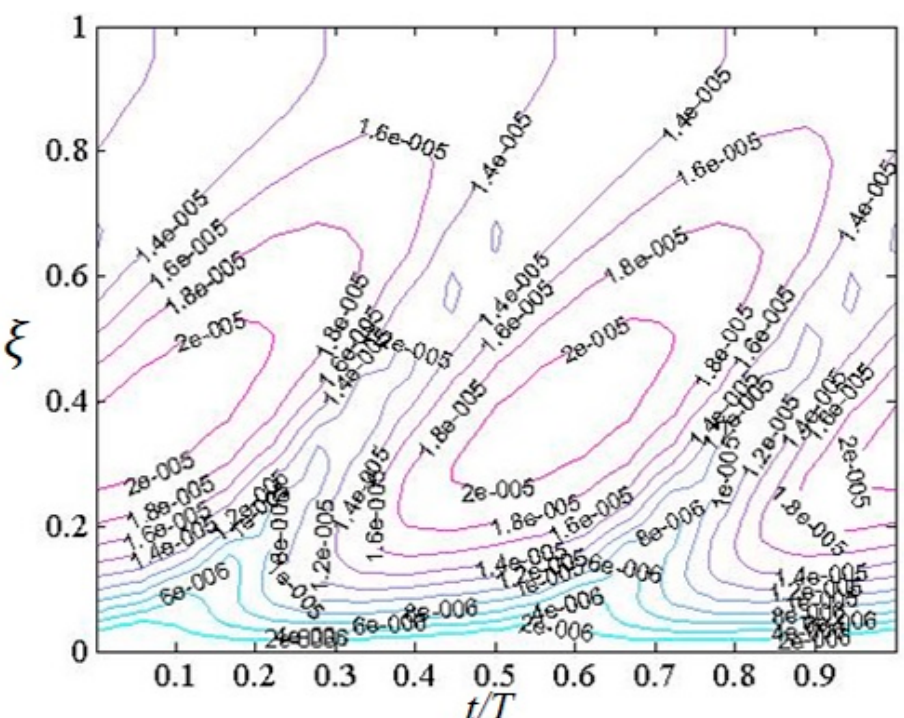
Figure 5. Temporal and spatial variation of dimensionless eddy viscosity for a sinusoidal wave obtained by the BSL k- ω model. Flow conditions: U m = U 0 = 3.63 m/s; a m = 1.73 m; T = 3 s; k s = 1.5 cm; Re = 437000.